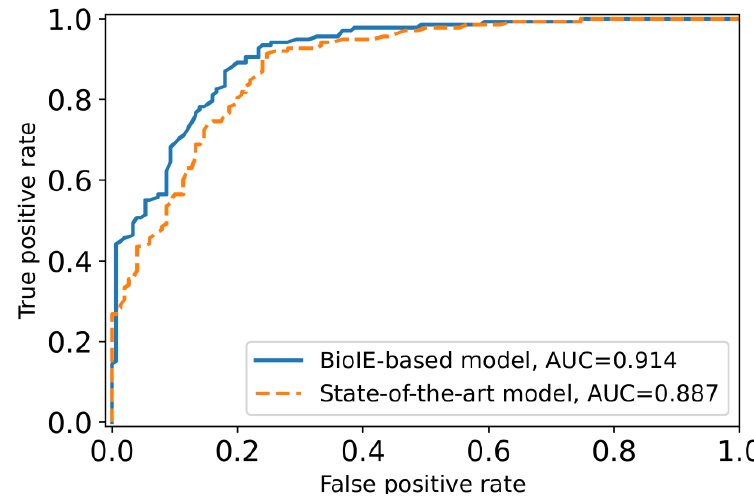
Figure 5. ROC curves for the validation test results for the BioIE-based multi-modality model and the state-of-the-art multi-modality model.